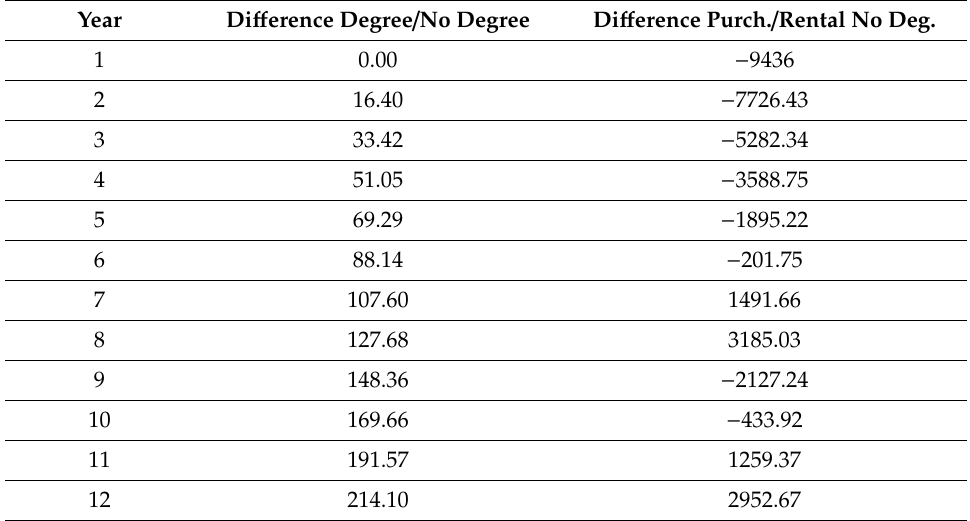
Table 5. Profit difference between battery degradation and non-battery degradation. Assuming a yearly replacement of the battery, it would be the di ff erence of battery renting vs. battery